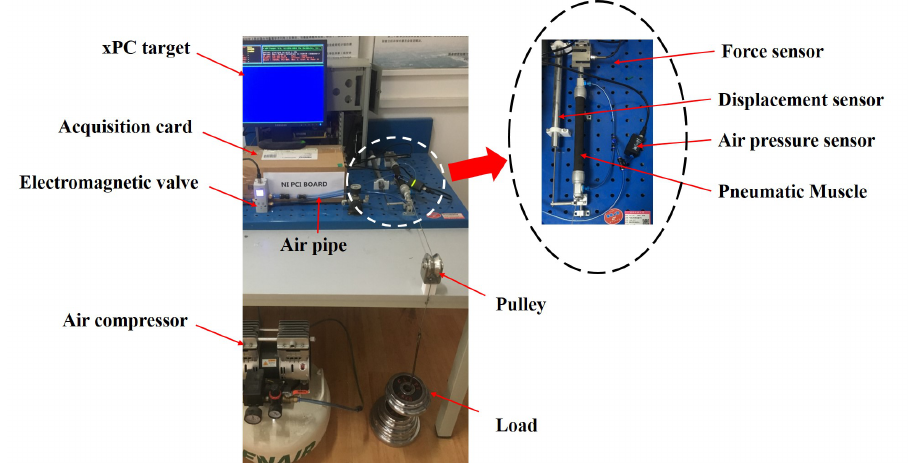
Figure 3. The PMA